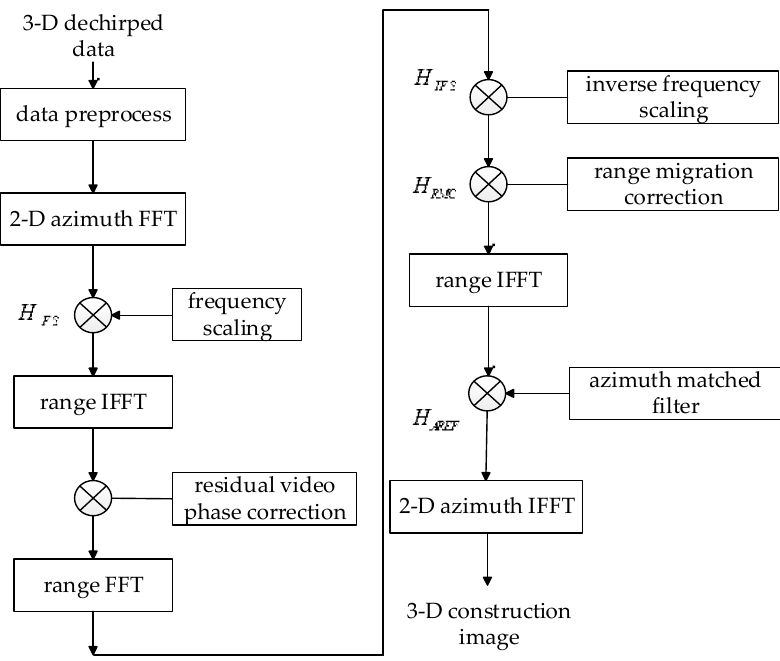
Figure 2. Flow chart of the near-field wideband 3-D frequency scaling algorithm. FFT = fast Fourier transform, IFFT = inverse fast Fourier transform, H FS = frequency scaling function, H IFS = inverse frequency scaling function, H RMC = range migration correction function, H AREF = azimuth reference function.